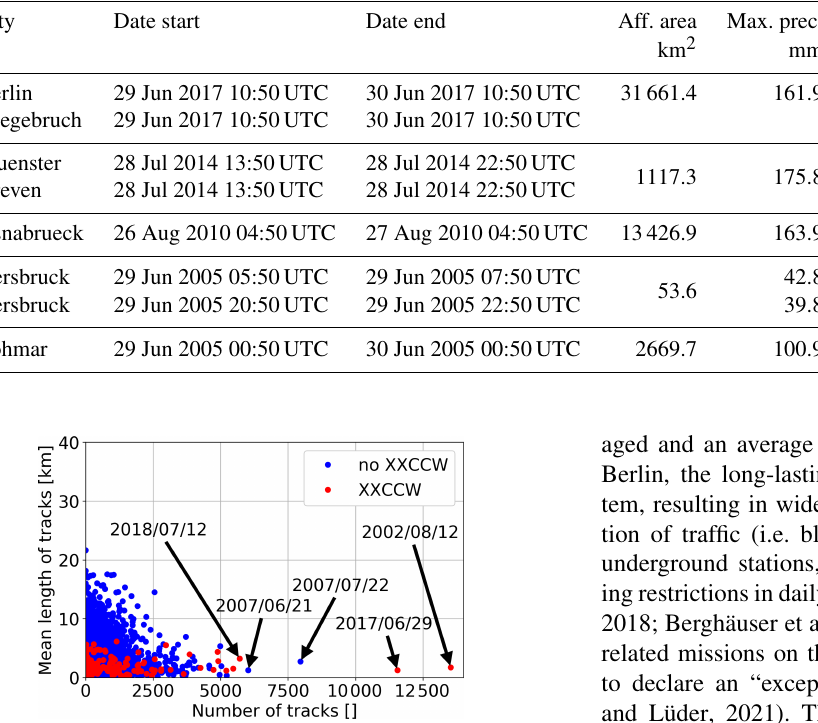
Table 1. Pluvial flooding events where surveys were conducted at affected households. Five events were surveyed at seven locations. The start and end dates, the affected area, the maximum daily precipitation, and the affected population are obtained from the CatRaRe database (Sect. 2), based on RADKLIM precipitation data. The overall losses within the municipality ( a ) are from GDV (2020) and refer to insured losses, while loss values with a ( b ) are from Hydrotec et al. (2008) and refer to total losses (non-insured and insured losses). Losses are referred to by constant 2019 prices. Note that Hersbruck was hit by two events in close succession, which are listed separately.